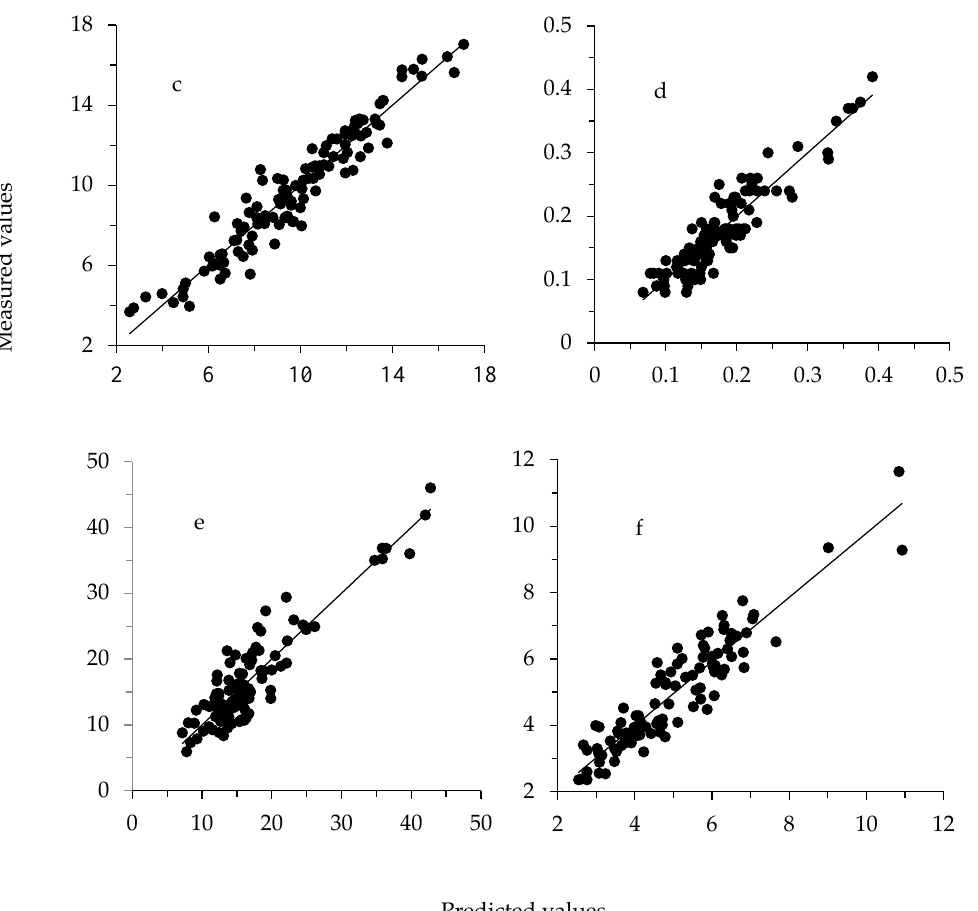
Figure 2. Linear regression plot of measured versus predicted values (dry matter basis, DM) for ( a ) S, g / kg DM; ( b ) K, g / kg DM; ( c ) P, g / kg DM; ( d ) Li, mg / kg DM; ( e ) Sr, mg / kg DM; and ( f ) B, mg / kg DM. Values in leave-one-out cross-validation ( n = 119).